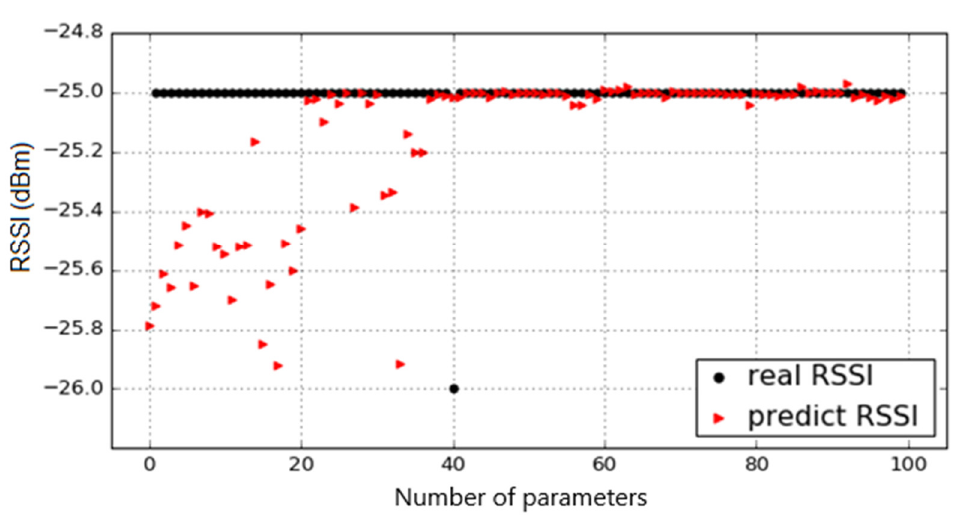
Figure 8. Example of a prediction using the random forest regressor method.